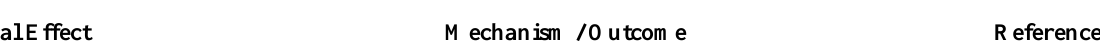
Table 1. Anti-oxidative, anti-inflammatory, anti-tumor, and anti-microbial effects and related mechanisms/outcomes of honokiol and/or